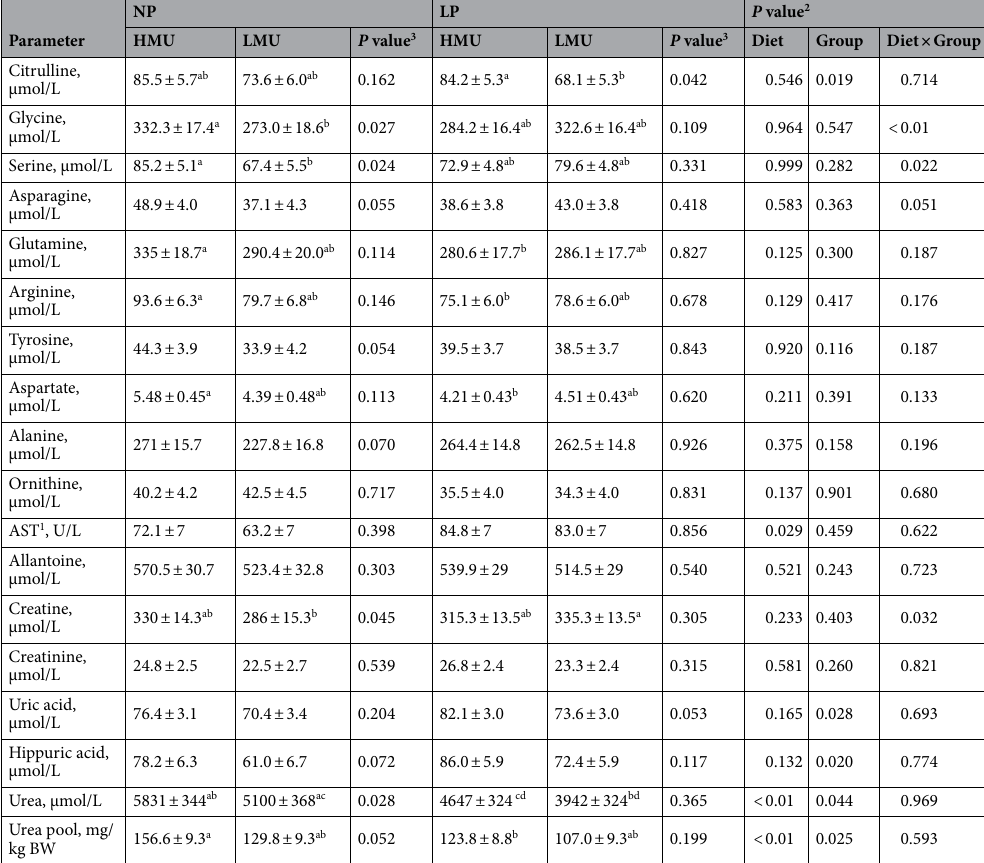
Table 3. Plasma N-metabolite concentrations and urea pool size of dairy cows with low (LMU) and high milk urea concentration (HMU) fed normal (NP) and low (LP) dietary crude protein level under conditions 97% of within one row indicate P < 0.05 (Tukey test). 1 AST, aspartat-aminotransferase. 2 P value from ANOVA analysis. 3 P value from Tukey slice